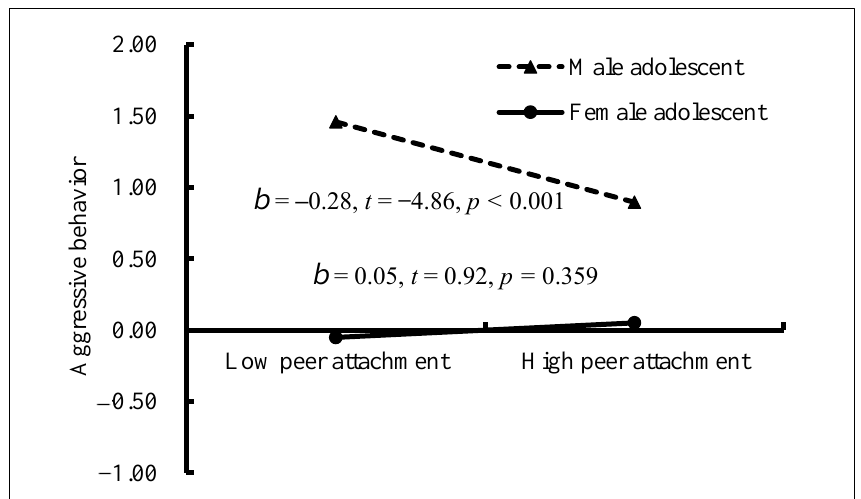
Figure 3. Aggressive behavior among adolescents as a function of peer attachment and gender.